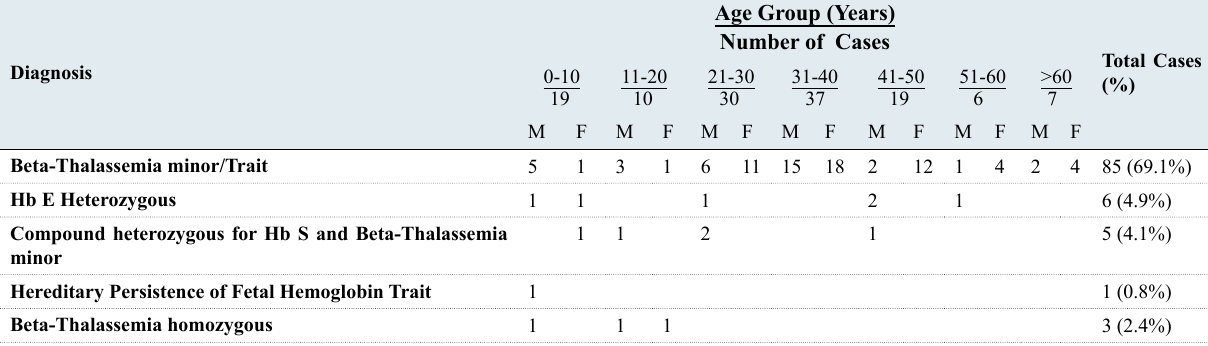
Table 1: Prevalence of hemoglobinopathies in various age